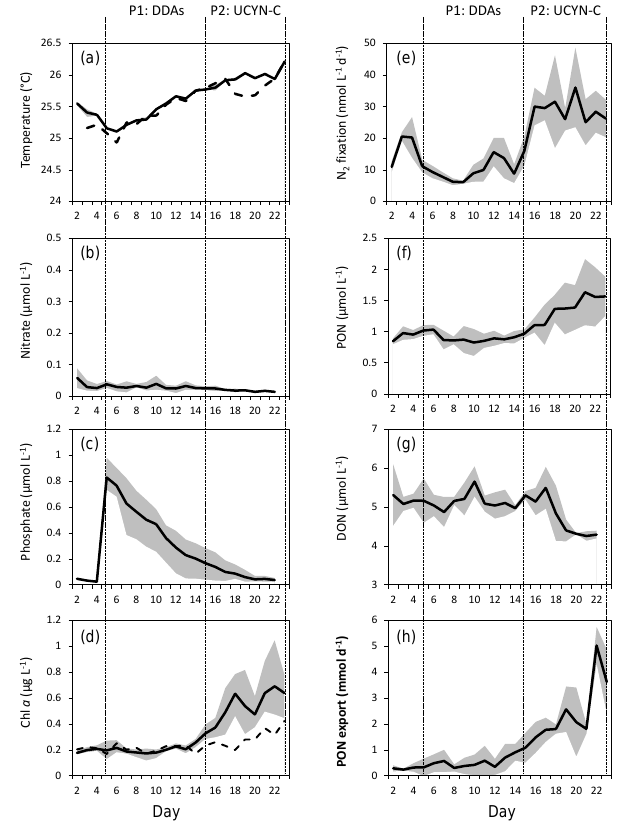
Figure 3. Evolution of sea surface temperature ( ◦ C; a ), NO − (µmolL − 1 ; b ), DIP (µmolL − 1 ; c ), Chl a (µgL − 1 ; d ), N 2 fixa- tion rates (nmolNL − 1 d − 1 ; e ), PON concentrations (µmolL − 1 ; f ), DON concentrations (µmolL − 1 ; g ) and PON export (mmold − 1 ; h ) over the 23 days of the VAHINE mesocosm experiment. Lines represent the average of the three mesocosms and shaded areas rep- resent the measured min and max values. Dashed lines represent the values represent the values in lagoon waters (outside the meso-